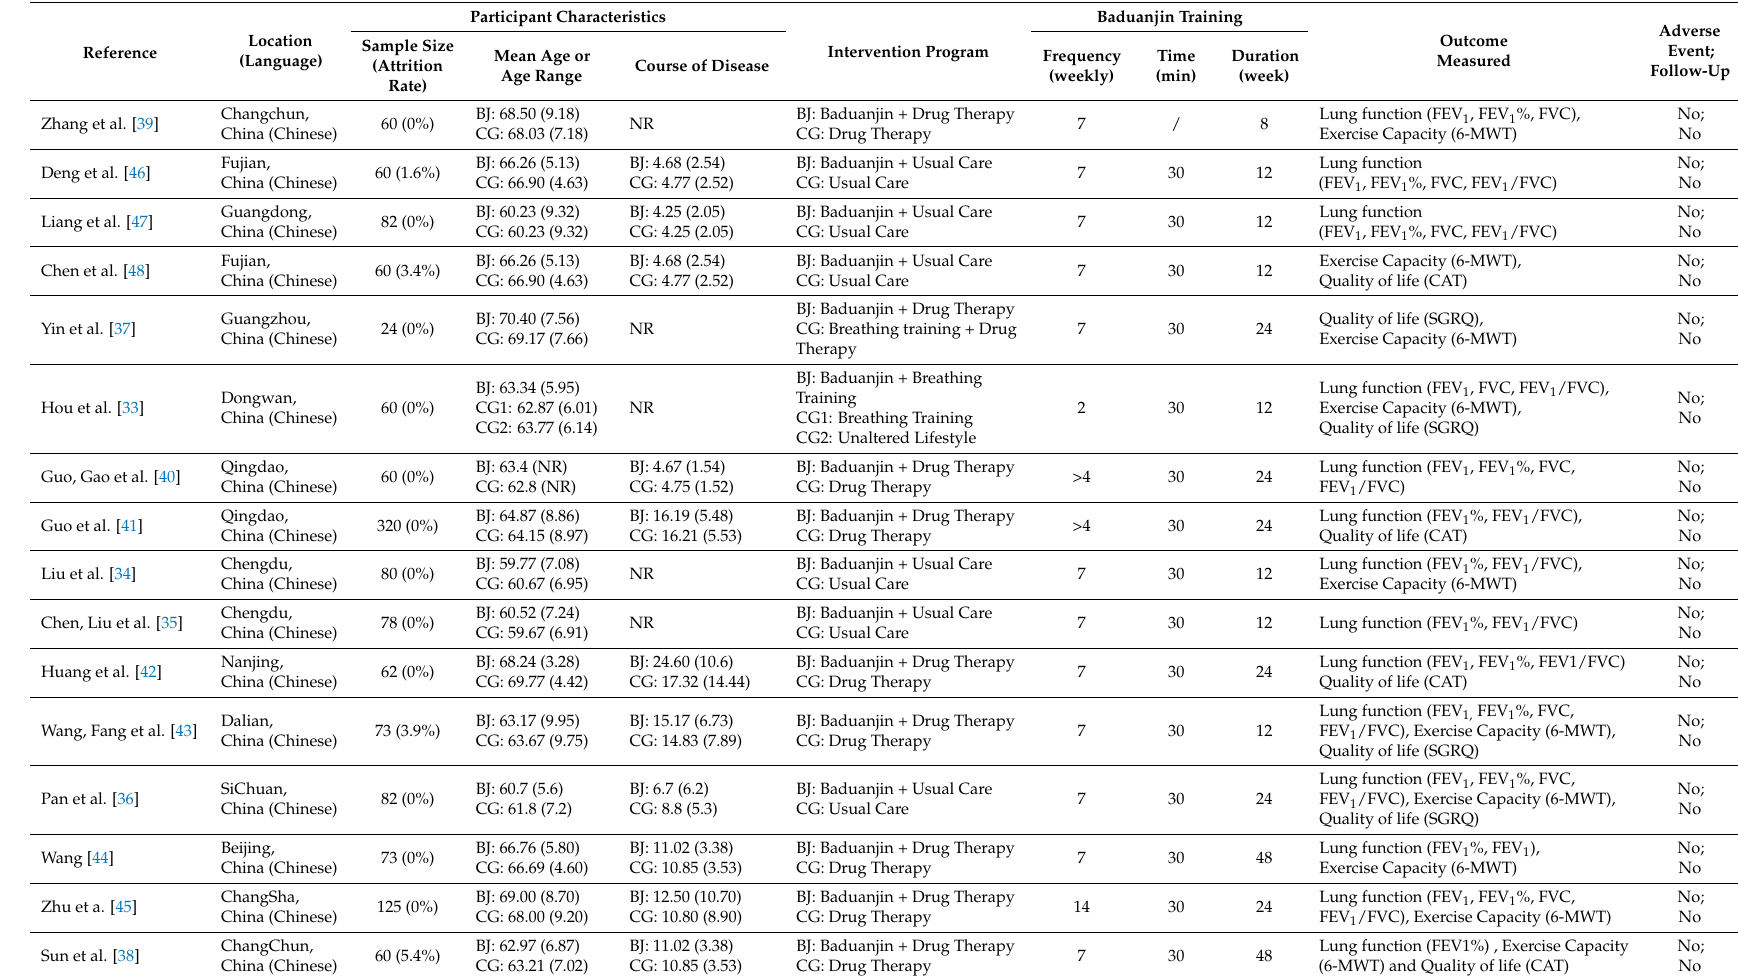
Table 1. Summary of randomized controlled